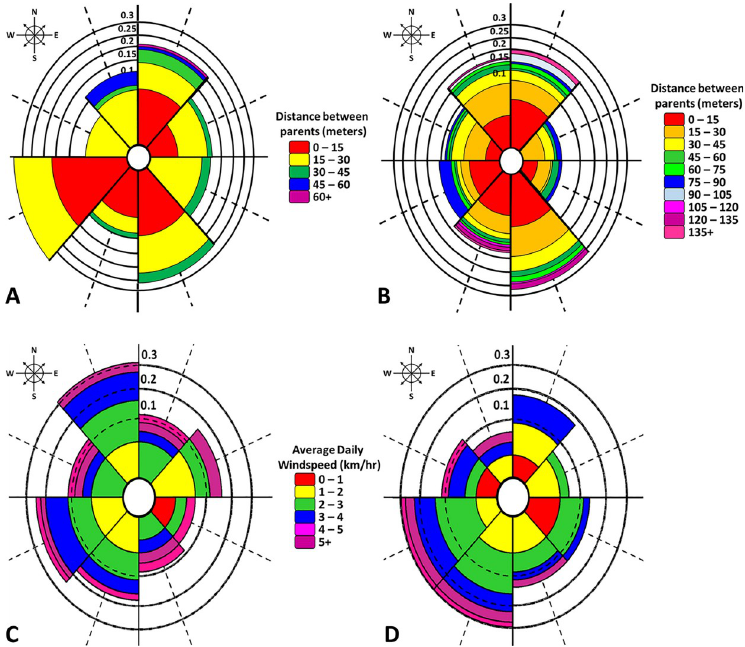
Fig 3. Rose diagrams showing frequency, distance, and direction of pollen that resulted in production of an offspring. The observed distribution of successful mating was divided into eight sectors ( A ) Lugar farm orchard (LO) and (B) Vallonia orchard (VO) obtained from pooled data and all verified mating events. Direction and speed of wind ( C ) West Lafayette, Indiana and ( D ) Bloomington, Indiana, the closest weather stations to LO and VO. Scale shows: 0.1 = 10%, 0.15 = 15%, 0.2 = 20%, 0.25 = 25% and 0.3 = 30%.